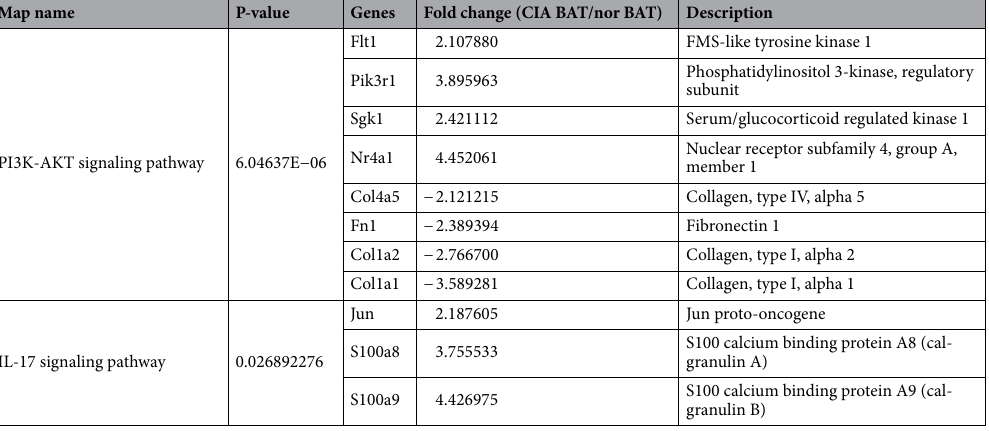
Table 1. The significant pathways in CIA BAT compared to nor BAT ( P <